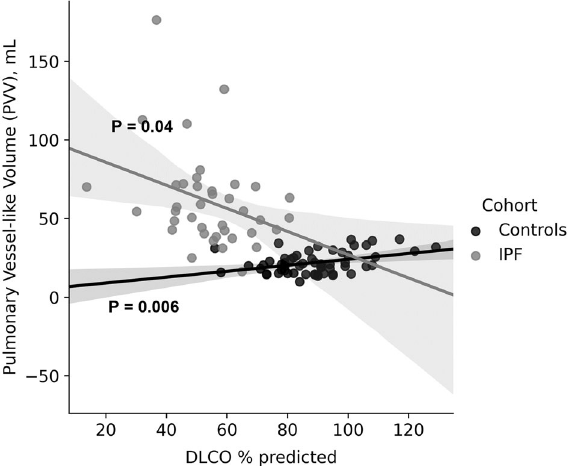
Figure 5. Relationships between estimated pulmonary vessel-like volume (PVV) and percent predicted diffusion capacity for carbon monoxide (D L CO%) for IPF (grey) and controls (black). Control PVV has a positive relationship, and IPF a negative relationship, with D L